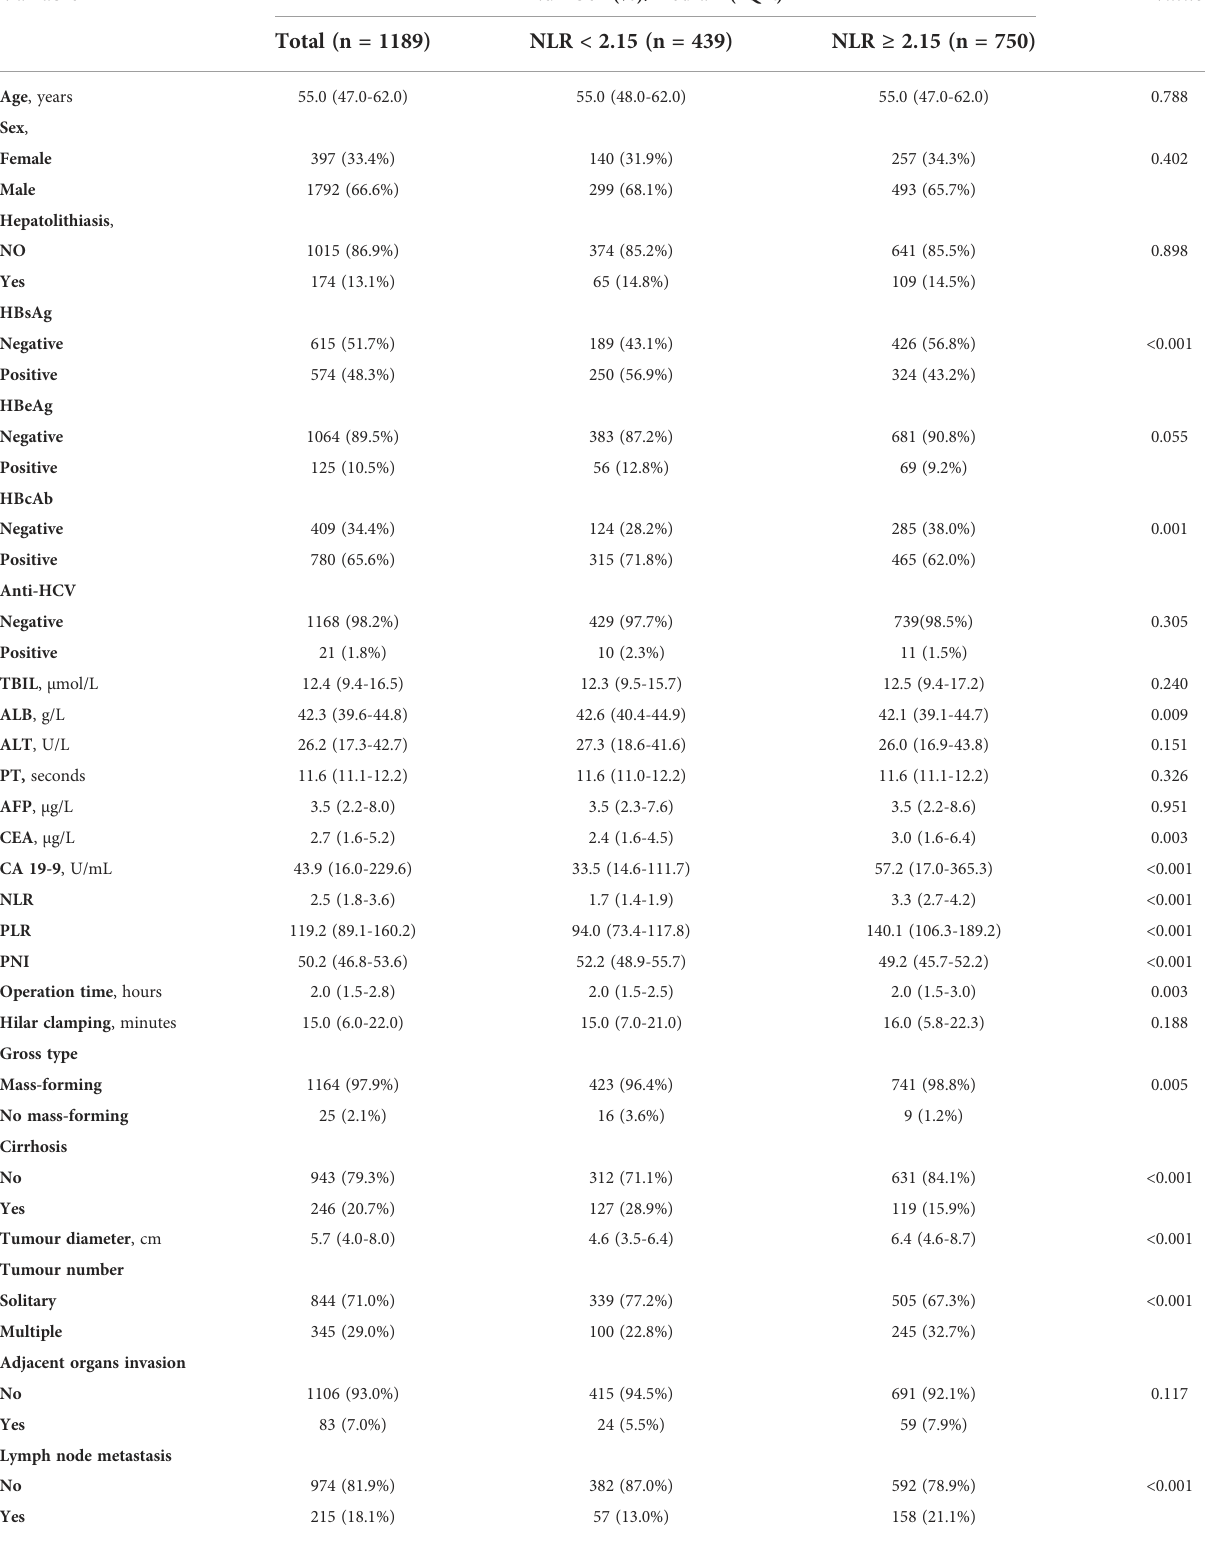
TABLE 1 Baseline clinicopathological